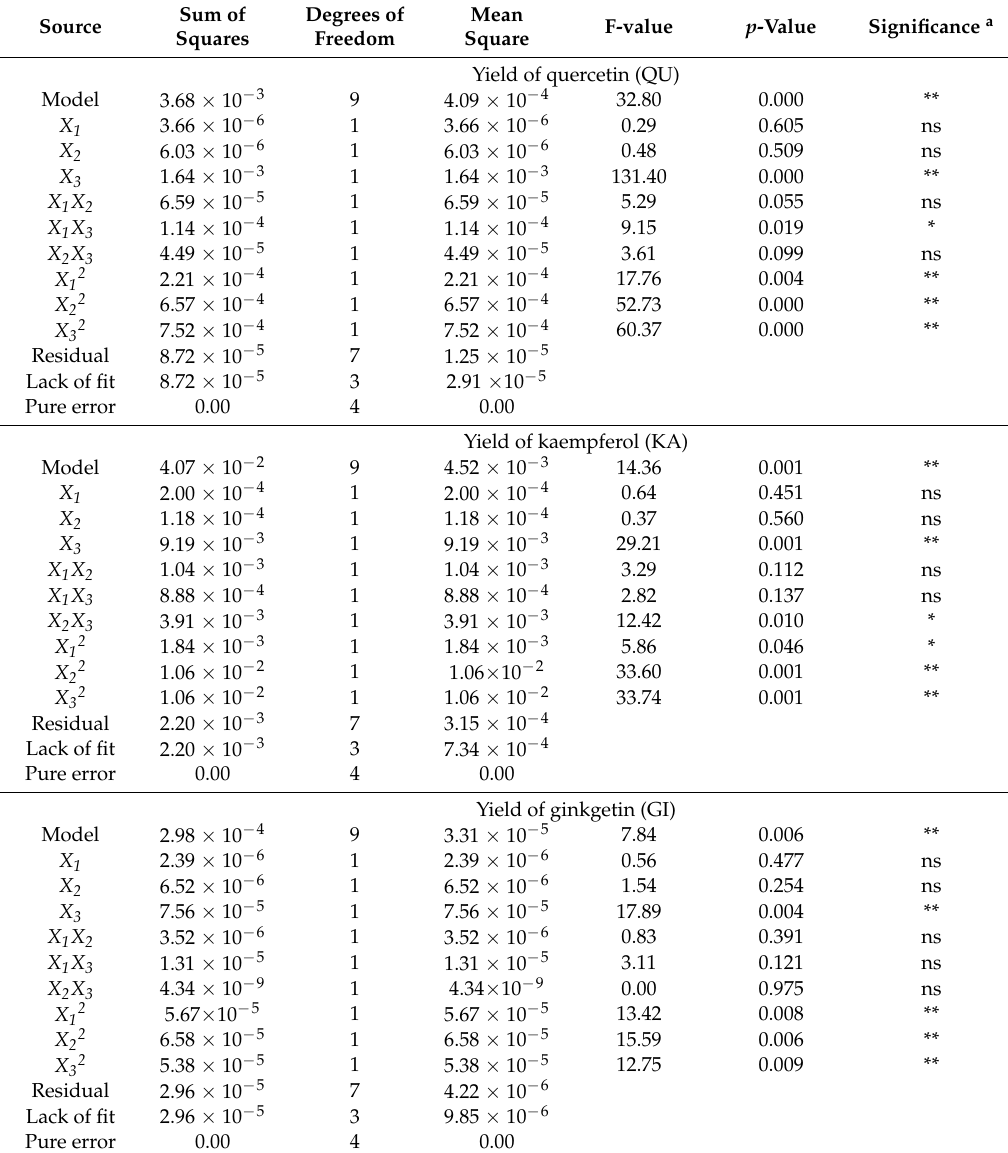
Table 3. Analysis of variance (ANOVA) for response surface quadratic